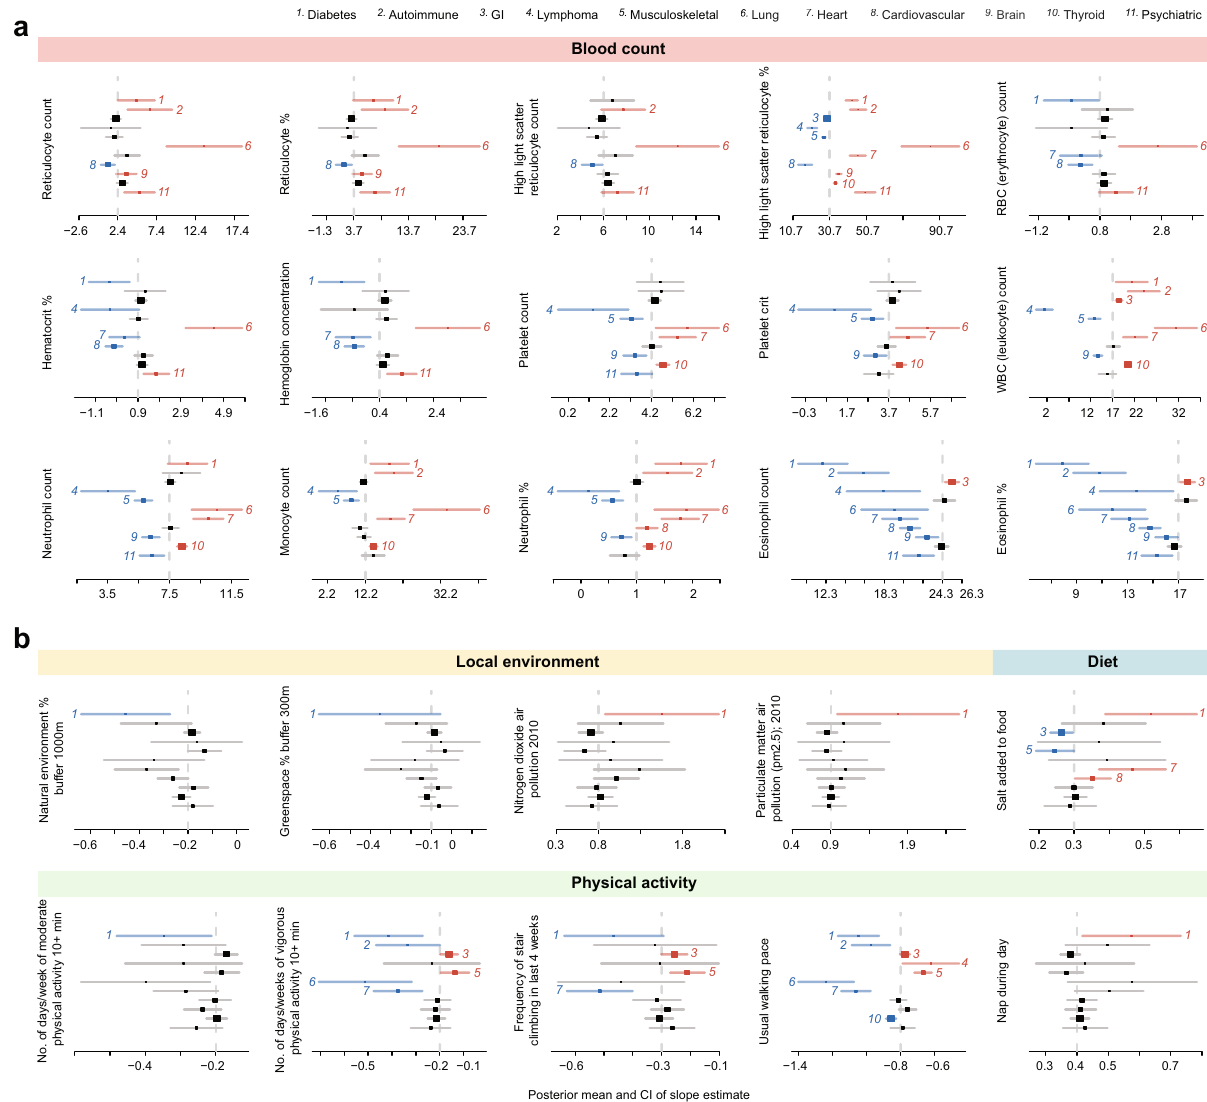
Fig. 4|Differentialasthmaassociationswithhealth-relatedphenotypesacross subgroups. A total of 10 different categories of health-related phenotypes (140 different measurements in total) were subjectedto phenotypeassociationanalysis (see Methods for technical details and Supplementary Data 11 for the numbers of allocated cases and controls in each subgroup). We fi rst computed phenotypes ’ slope estimates of asthma associations within each subgroup and in the any-CDs group. The direction and strength of the association are characterized by the sign and absolute value of the slope, respectively. a Heterogeneous slope estimates related to blood count. We assessed the heterogeneity in these slope estimates acrosssubgroupsforeachphenotype,andbenchmarkedagainsttheslopevaluefor thatphenotypeinthe any-CDs group.Eachphenotypeis presented asa meta-plot, which shows the posterior means (as squares) and 95 percent con fi denceintervals (aserror bars)of the slopesfromsubgroups 1to 11that werealso discovered in UK